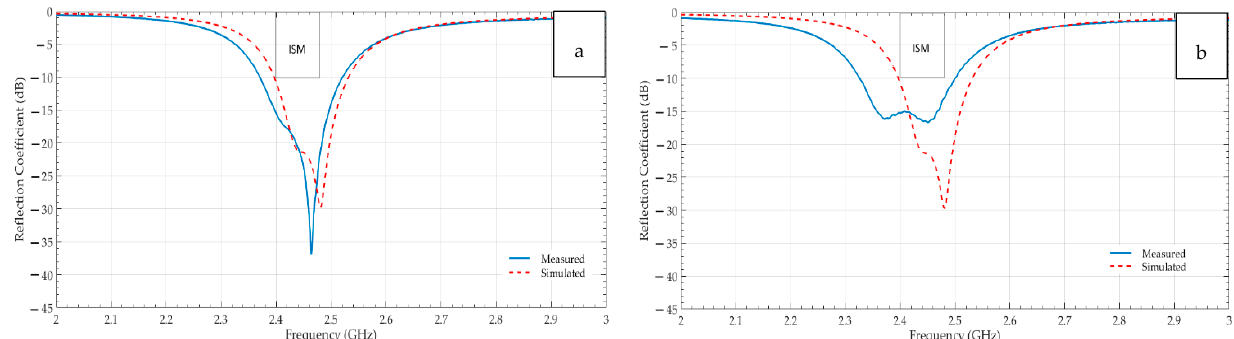
Figure 8. Simulated and measured reflection coefficients-S11 of ( a ) non-perforated PRAG based RRMPA ( b ) perforated PRAG based RRMPA.